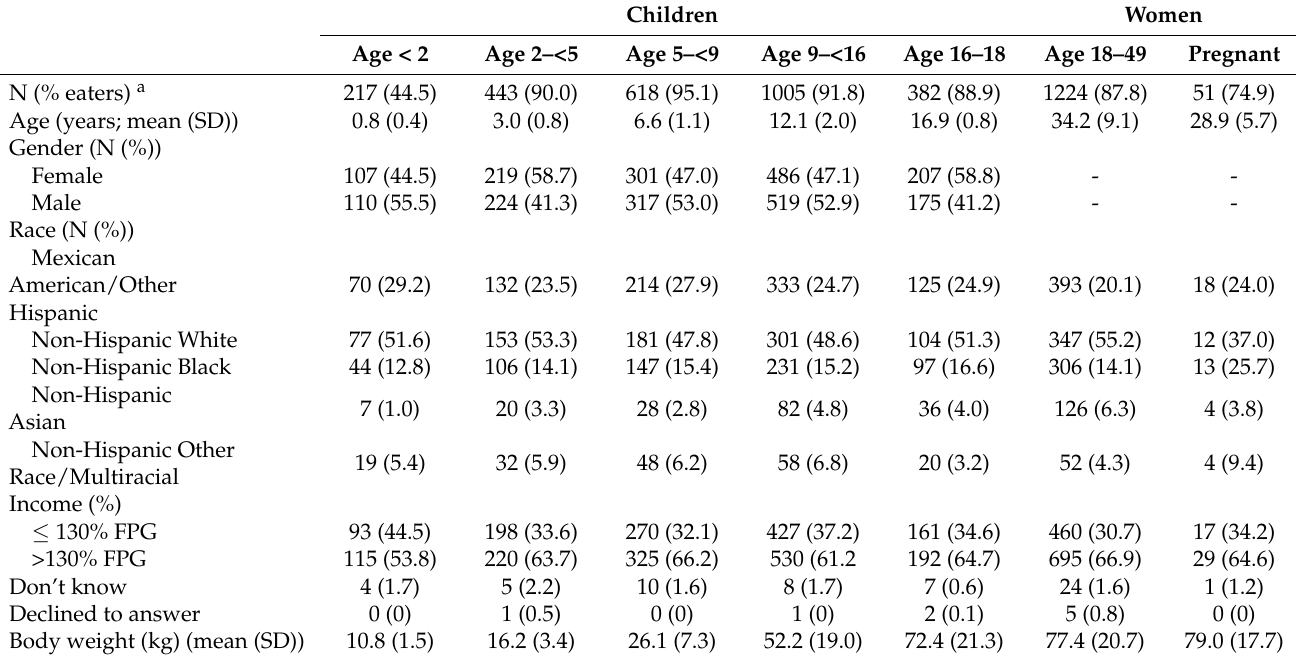
Table 1. Demographic characteristics of AFC eaters (children and women of childbearing age) who consumed at least one AFC on Day 1 and/or Day 2 (n = 2665 children and 1275 adult eaters,